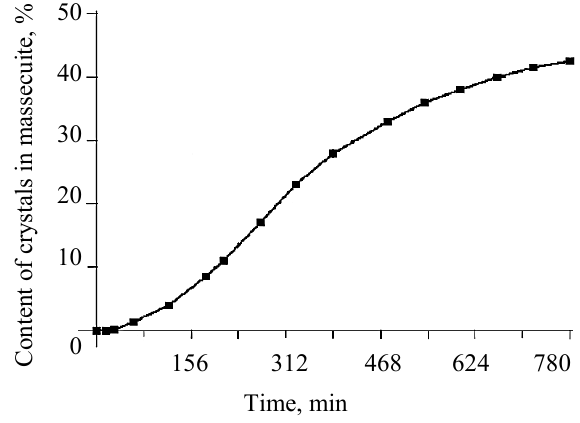
Fig. 8. Kinetics of crystallization of anhydrous glucose with a seed from the large (200 μm) hydrate glucose crystals wet with propanol under polythermic conditions with a decrease in temperature from 60 to 38°C.